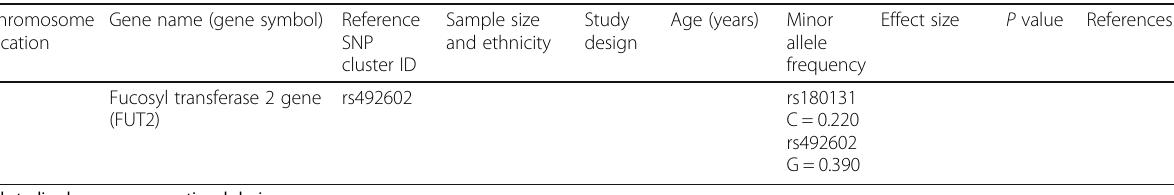
Table 2 Candidate gene association studies examining the association of SNPs with vitamin B12 concentrations. Candidate gene association studies testing the association between SNPs and vitamin B12 concentrations. The chromosome location, gene name, reference SNP cluster ID, sample size and ethnicity, study design, mean age, observed frequency of the minor allele in the population, effect size and P value are shown in the table. The order of SNPs reflects the order of the chromosome location